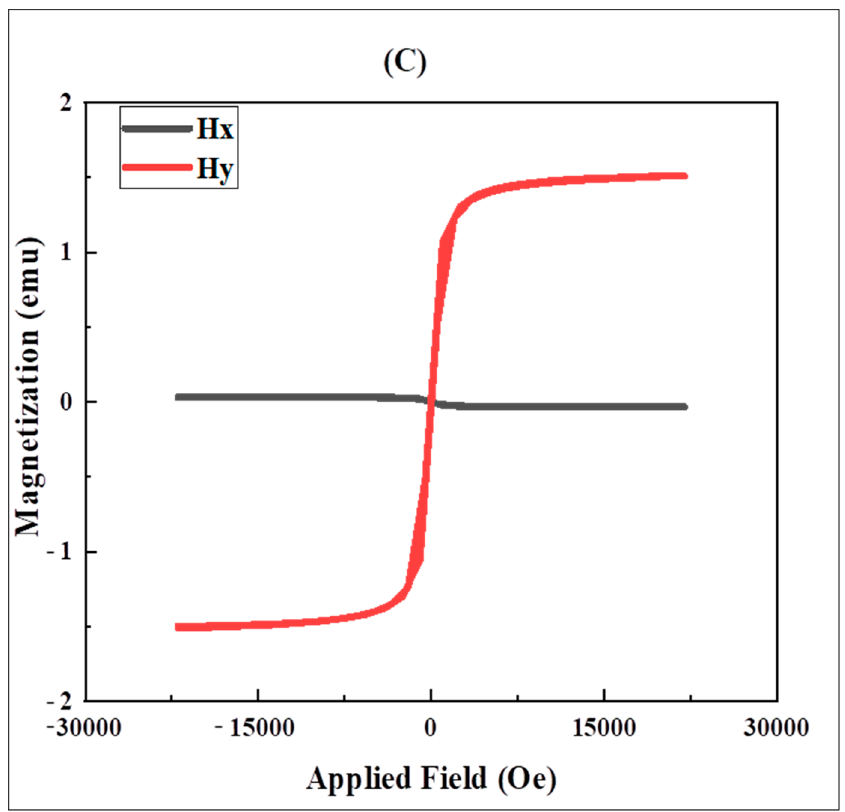
Figure 11. VSM for concentrate of ( A ) sample A, ( B ) sample B, and ( C ) sample C.